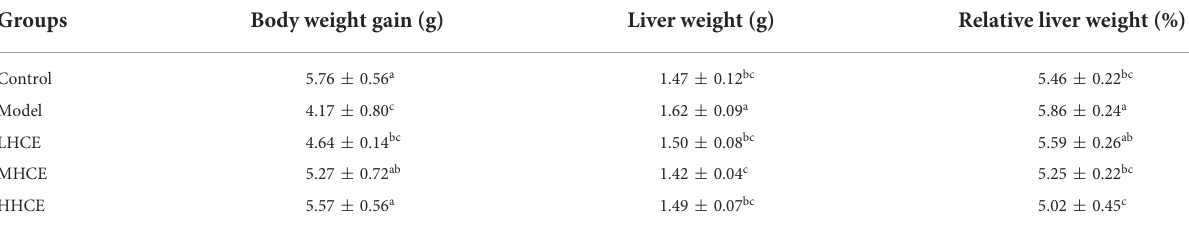
TABLE 2 Effects of different doses of herbal chicken essence (HCE) on body weight gain, liver weight, and relative liver weight of D-galactose-induced aging mice. Groups